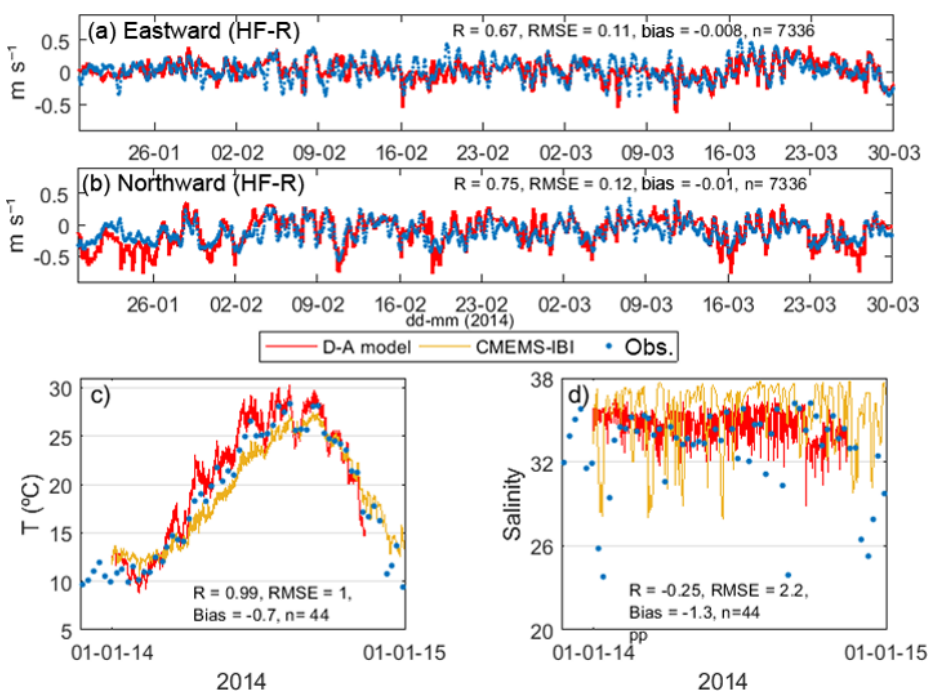
Figure 3. Eastward (a) and northward (b) water surface currents for the D-A model and HF-R at HF (Fig. 1) are shown. SST (c) and SSS (d) validation of the local model D-B (red), CMEMS-IBI (yellow) and observations (blue) at T (Fig.